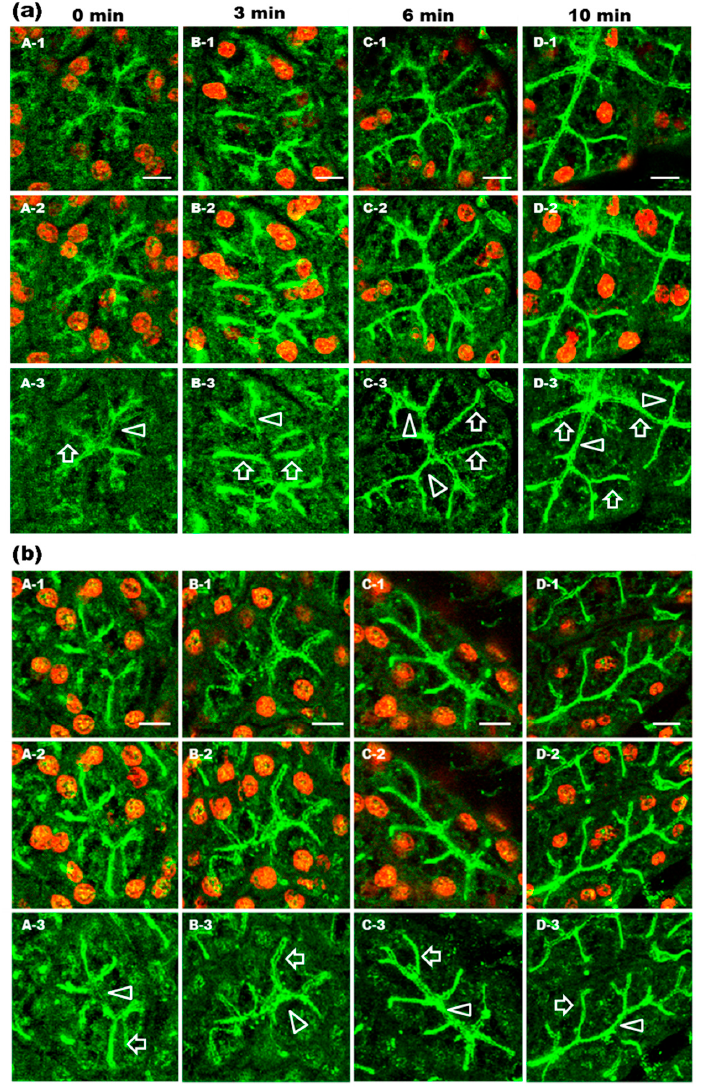
Figure 1. Immunohistochemical analysis of aquaporin-5 (AQP5) and ganglioside GM1 distributions in rat parotid acinar cells after phenylephrine injection. Parotid glands were obtained from rats 0 ( A ), 3 ( B ), 6 ( C ), and 10 ( D ) min after phenylephrine (0.25 mg/kg) injection. Tissue sections were fixed in ethanol followed by incubation with anti-AQP5 ( a ) and anti-GM1 ( b ) antibodies. Alexa-488 was used to visualize AQP5 and GM1. Propidium iodide (PI) was used to stain nuclei. One section is presented in each single image ( ´ 1). Sixteen consecutive images produced by a confocal microscope were projected to generate a single image ( ´ 2). To get clear visualization of AQP5 localization in acinar cells, the 568 nm laser was turned off ( ´ 3). Arrow heads and arrows indicate apical plasma membrane (APM) and lateral plasma membrane (LPM), respectively. Scale bars: 10 µm.